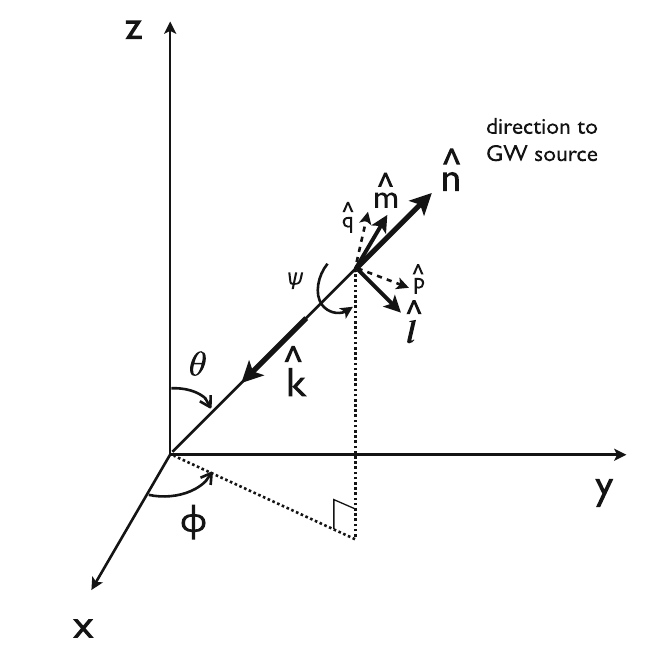
Fig. 87 Different choices for the unit vectors perpendicular to ˆ n . By rotating the unit vectors ˆ l , ˆ m by the angle ψ in the plane orthogonal to ˆ n , one obtains new unit vectors, ˆ p , ˆ q , in terms of which new polarization + ( ˆ n ,ψ) , (cid:7) × ( ˆ n ,ψ) , are basis tensors, (cid:7) ab ab